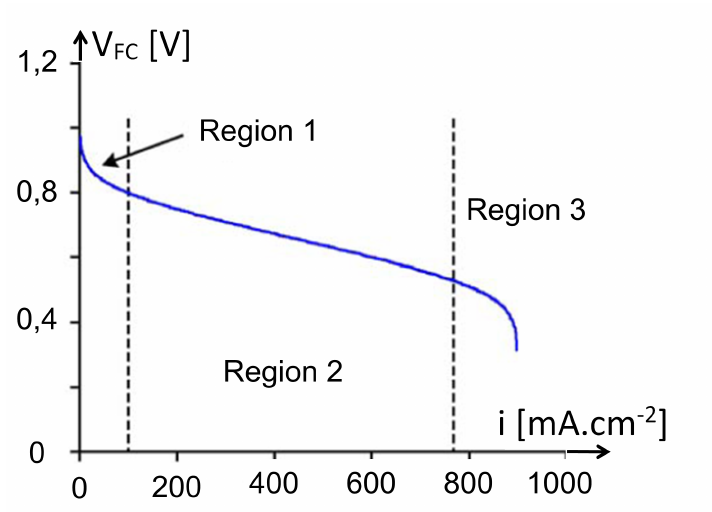
Figure 2. A typical PEMFC voltage–current curve.